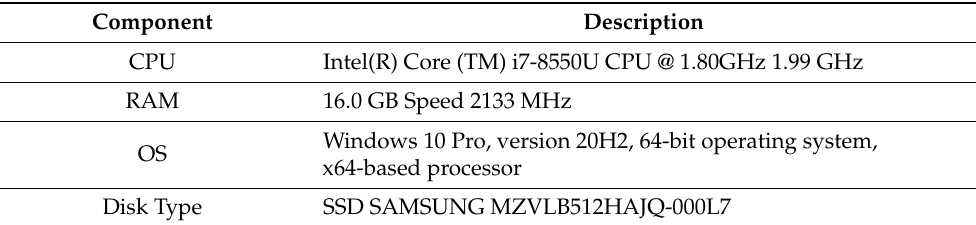
Table 1. Summary of local server